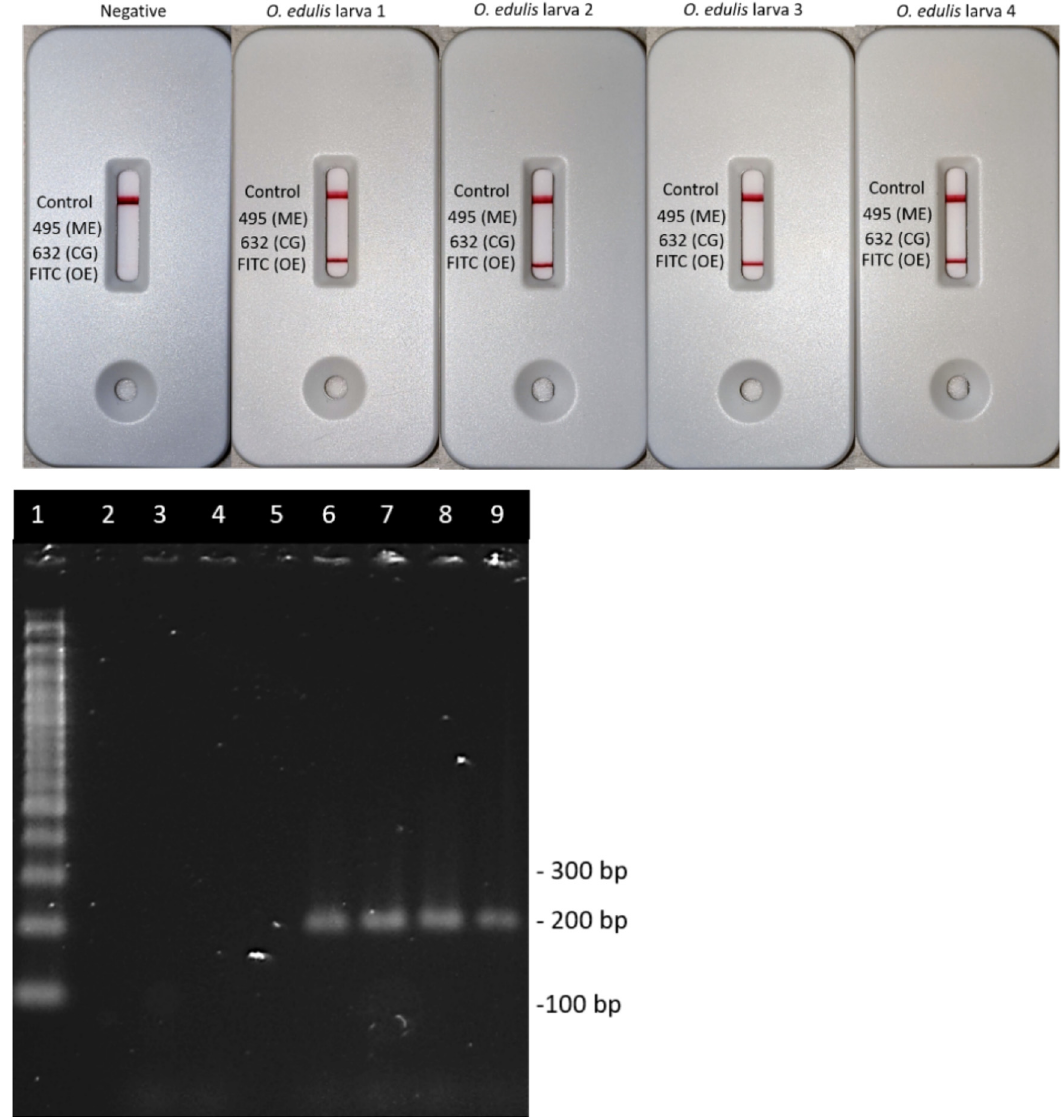
Fig. 6. PCR-nucleic acid lateral fl ow immunoassay (NALFIA) with a product of direct multiplex PCR of a single Ostrea edulis larva. The label on the left side of every pair of cartridges is indicating the test line for the existence of O. edulis (FITC OE), Crassostrea gigas (632 CG), and Mytilus edulis (495 ME). The most upper line on the cartridges is indicating the control line of each NALFIA. The cartridge on the left side is showing the non-template control, and the following four cartridges are showing NALFIA replicates with a single larva of O. edulis each. The image of the 3% agarose gel electrophoresis is showing the quality control of the NALFIA. The scheme of the different gel slots: 1: 100 bp marker, 2: empty, 3: non-template replicate 1, 4: non-template replicate 2, 5: empty, 6: O. edulis larva replicate 1, 7: O. edulis larva replicate 2,